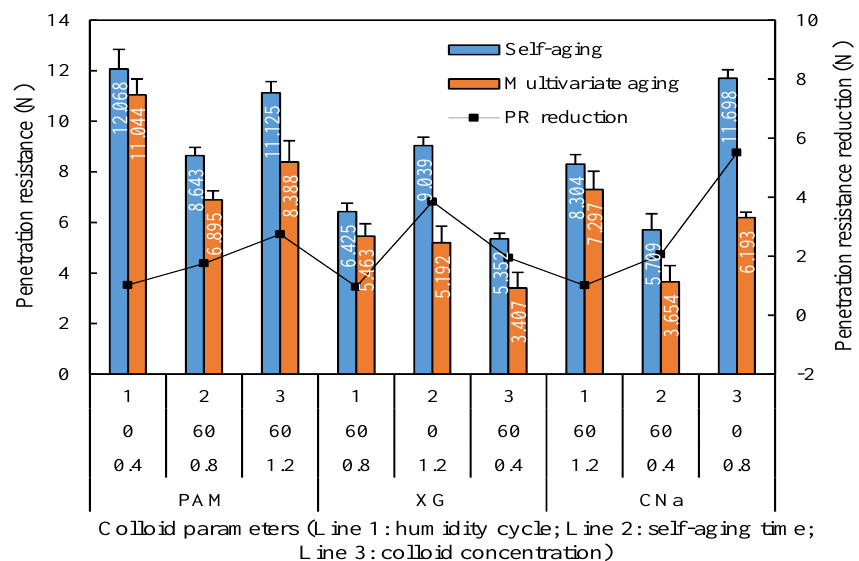
Figure 9. Humidity aged penetration resistance reduction for individual application.